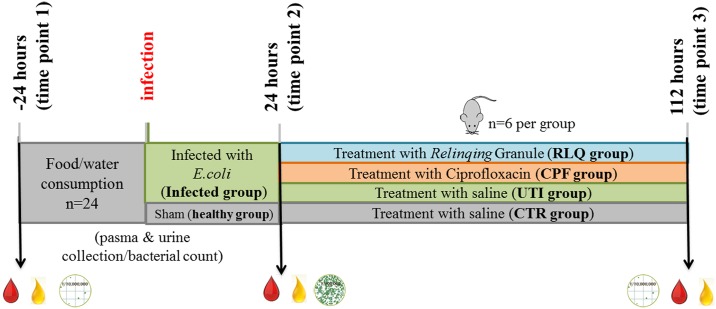
Experimental design for UTI metabolomics study.